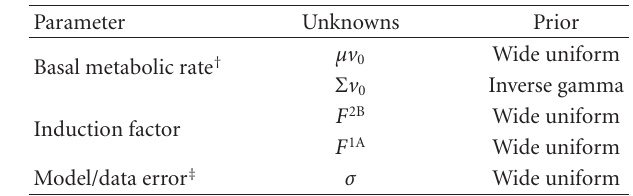
Table 4: Population-level parameters to be estimated by Bayesian